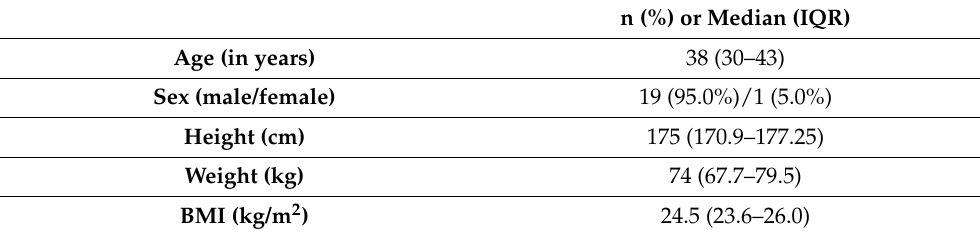
Figure 3. Individual change in snoring index (SI) before and after mouth-taping .